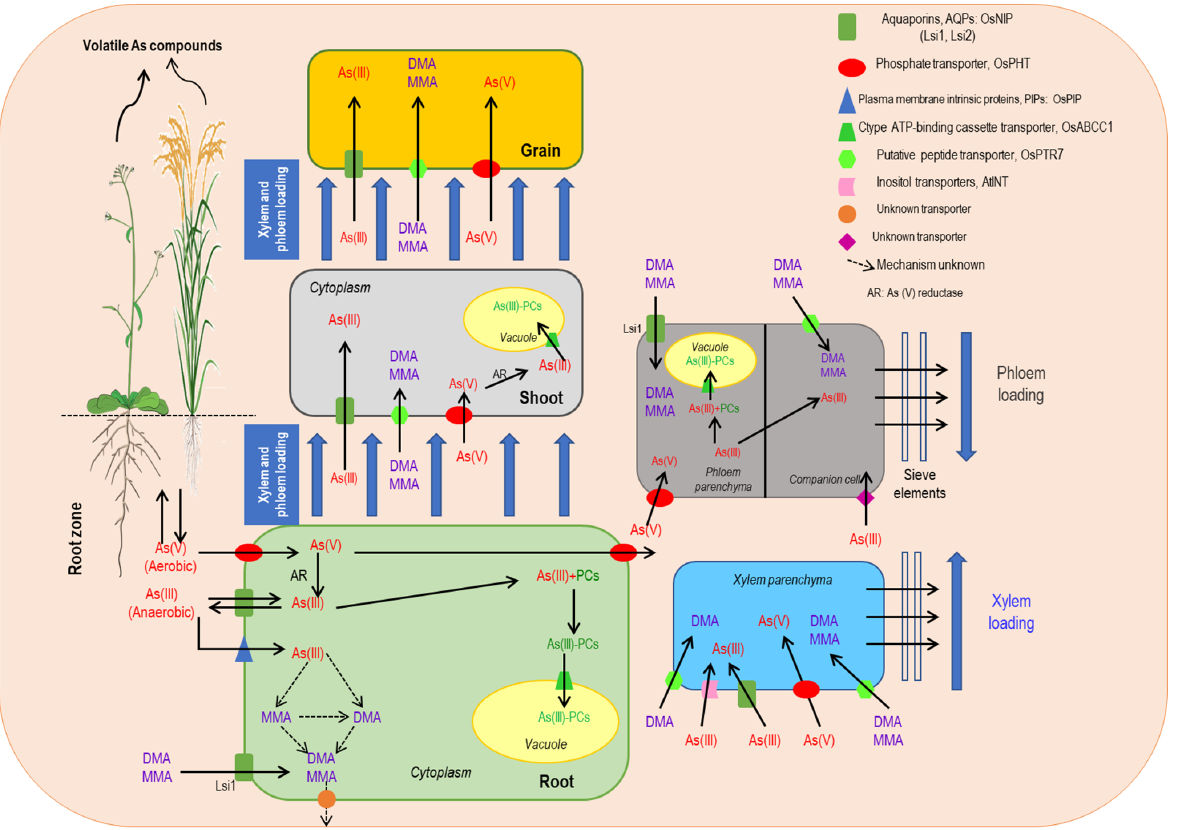
Figure 1. Schematic illustration of As uptake, translocation, accumulation and detoxification in plants. The dotted arrows indicate that the pathways/mechanism are not known properly. MMA: